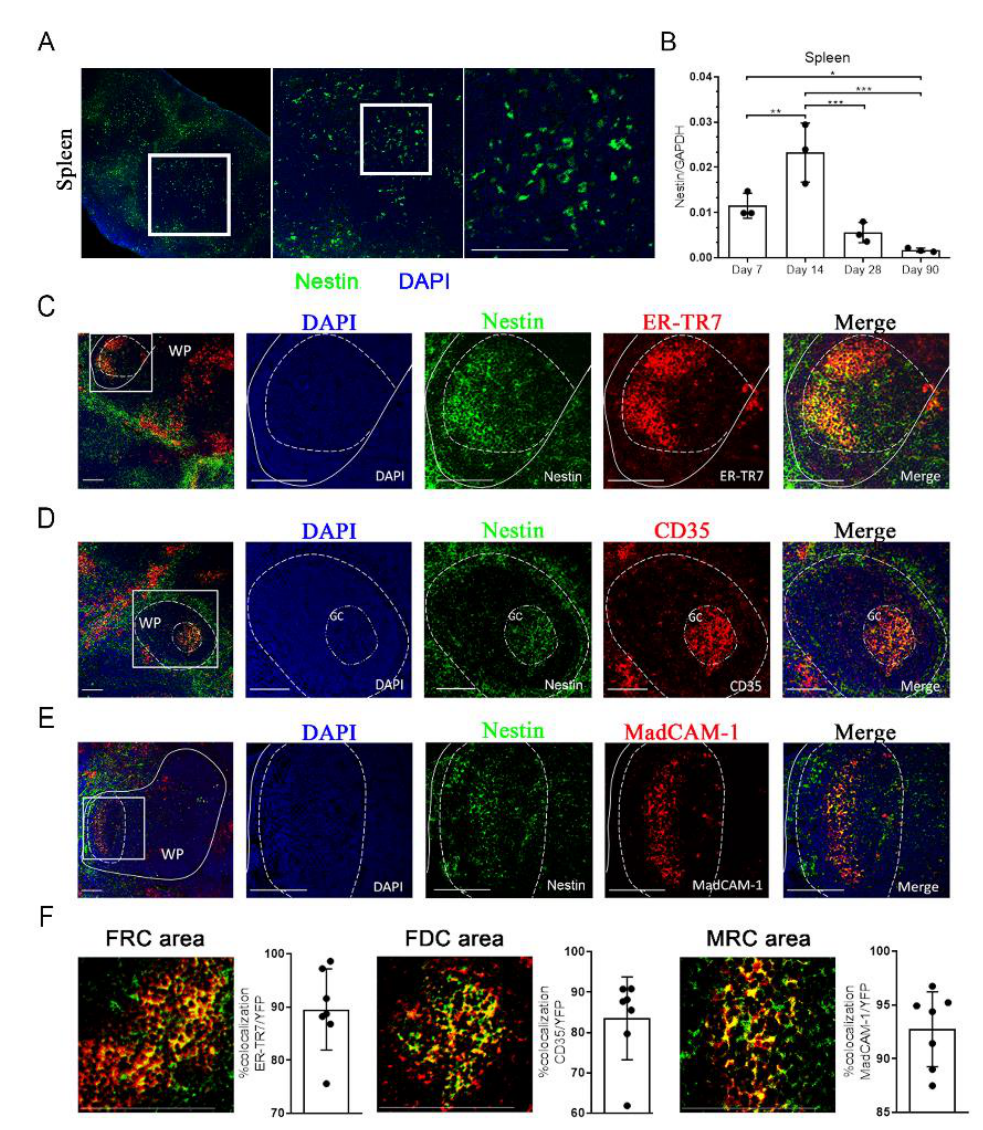
Figure 1. Characterization of Nestin expression in the spleen: ( A ) Nestin (green) expression in the spleens of Nes -GFP transgenic mice. Nuclei were counterstained with DAPI (blue). Scale bar, 100 µ m; ( B ) qRT-PCR analysis of Nestin gene expression in the spleen of normal mice on days 7, 14, 28, 90 after birth. The relative mRNA expression levels of Nestin were normalized to reference GAPDH controls. n = 3. ( C – E ) Immunohistochemical analyses showed that the Nes -GFP + cells in the spleen expressed markers of FRCs, FDCs, and MRCs; ( C ) ER-TR7 (FRCs); ( D ) CD35 (FDCs); ( E ) MadCAM-1 (MRCs). Nuclei were counterstained with DAPI (blue). Scale bar, 50 µ m. White Pulp, WP; Germinal Center, GC; ( F ) The co-expression area of Nes -GFP + cells with ER-TR7, CD35, and MadCAM-1 was counted. n = 7.Data represent mean values ± SD of three independent experiments. * p < 0.05, ** p < 0.01, *** p <